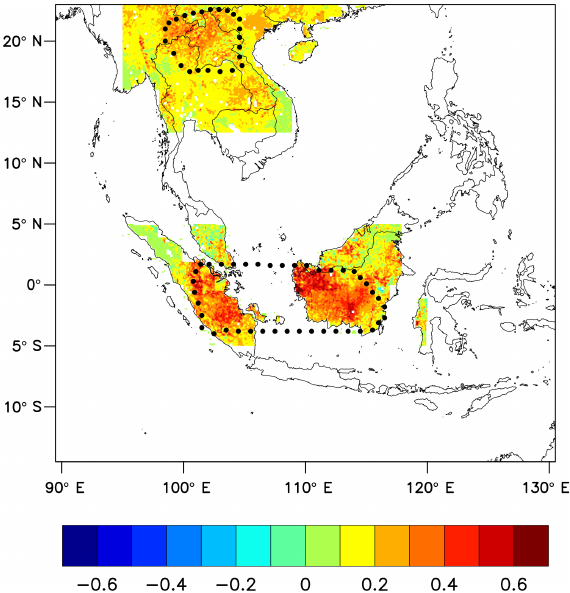
Figure 4. Regression coefficients( δ 1 ) associated with fire count for REG 1 . Regions of highest AOD variability from the EOF analysis are delineated by black